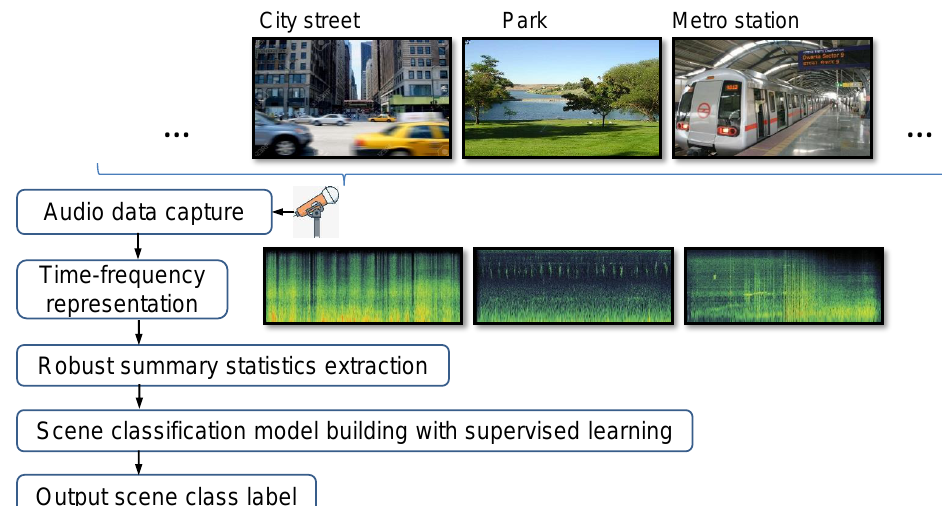
Figure 1. General framework of acoustic scene classification system. ASC can be performed by examining homogeneous structures of audio